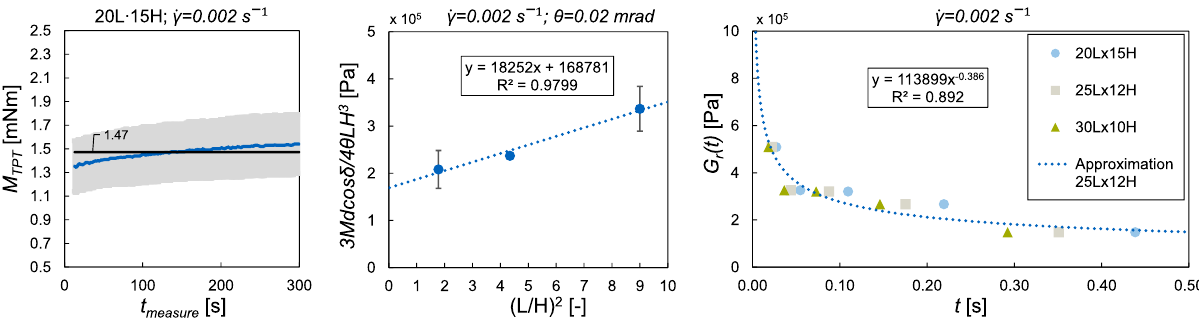
Figure 3: Analysis example – Thin Plate Torsion Test: measured torque M TPT vs. measurement time t measure (left); 3Mdcos δ /4 θ LH 3 vs. (L/H) 2 (middle); relaxation modulus G r vs. time t (right).